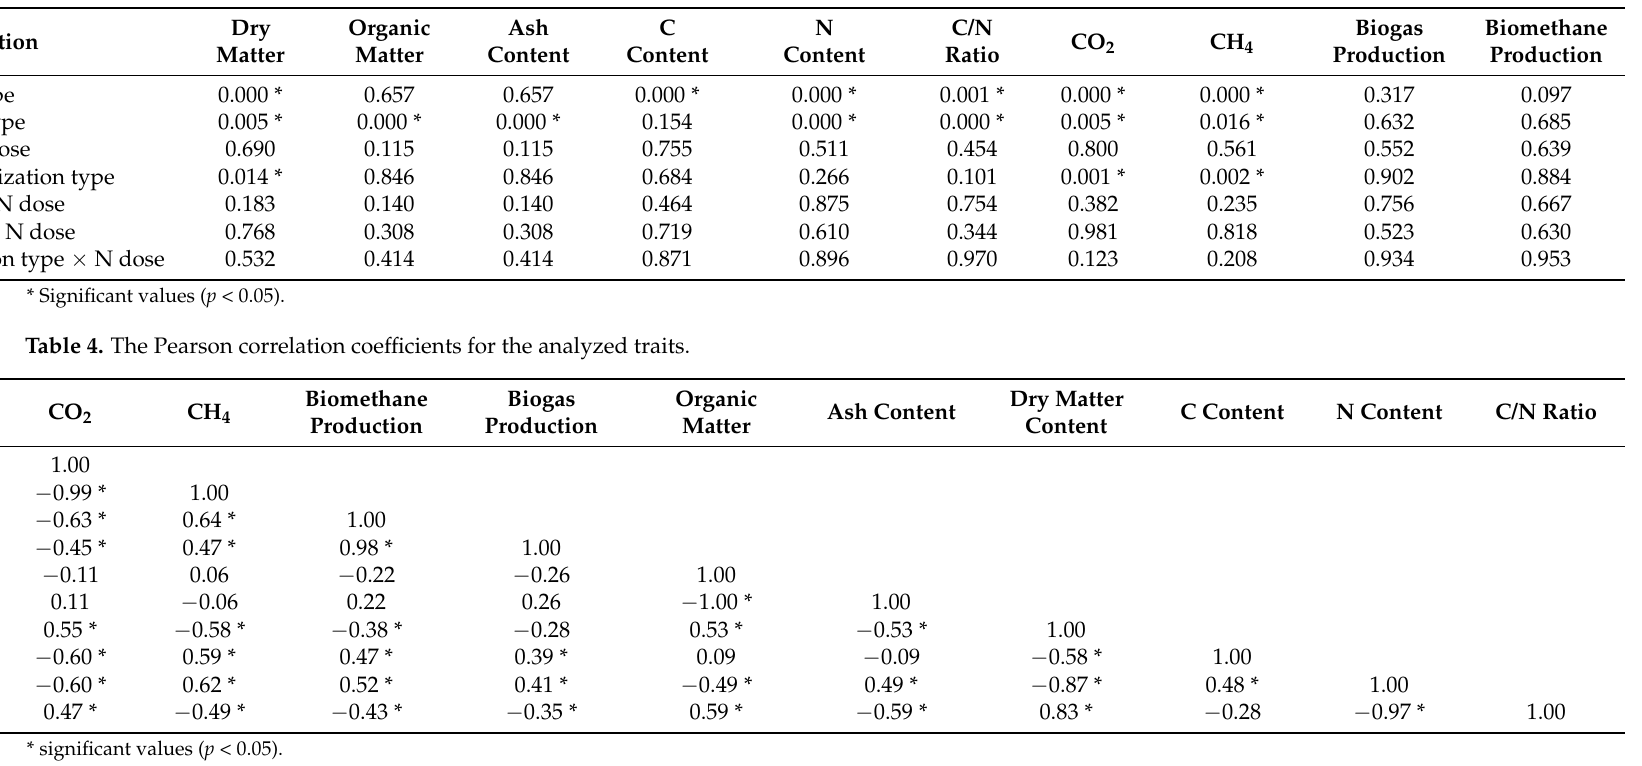
Table 3. Analysis of variance ( p -values) for the analyzed features.